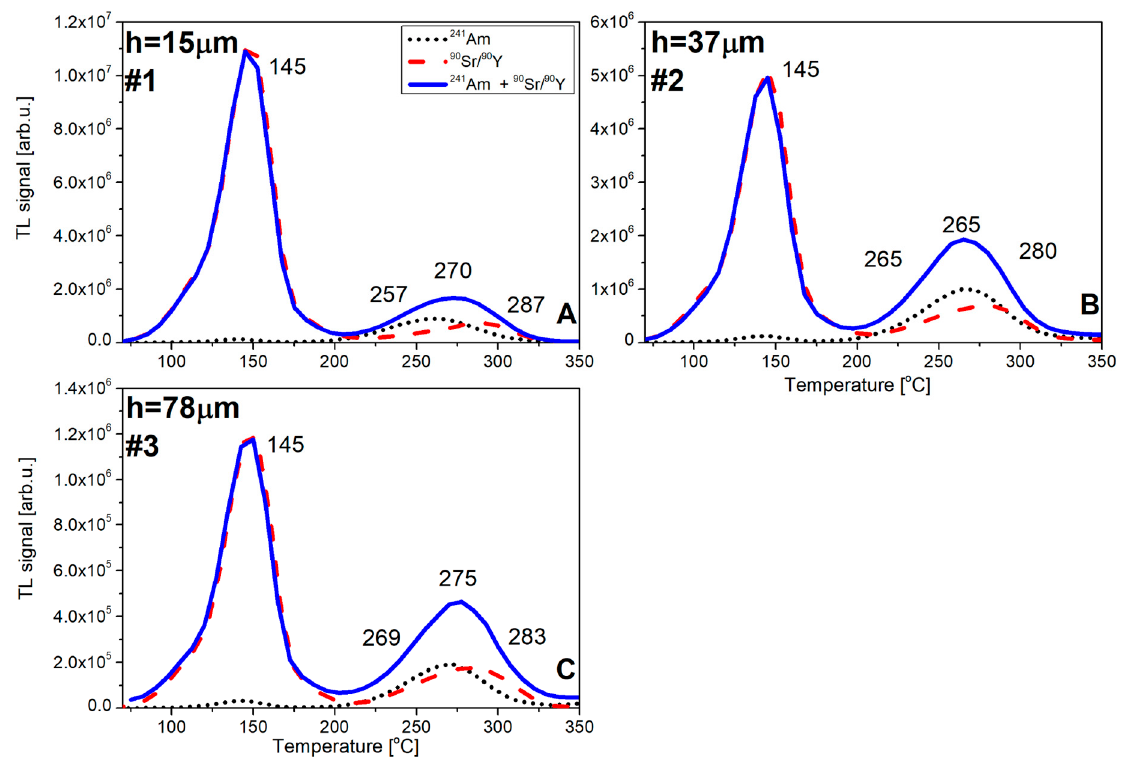
Figure 12. TL glow curves of LuAG: Ce SCF/YAG SC (( A )—h = 15 µ m, ( B )—h = 37 µ m, ( C )— h = 78 µ m) after irradiation with different irradiation procedures ( 241 Am, 90 Sr/ 90 Y, and mixed radia- tion). The values of fluence and dose are: Φ = 1.6 × 10 11 [cm − 2 ] and D β = 120 [Gy],